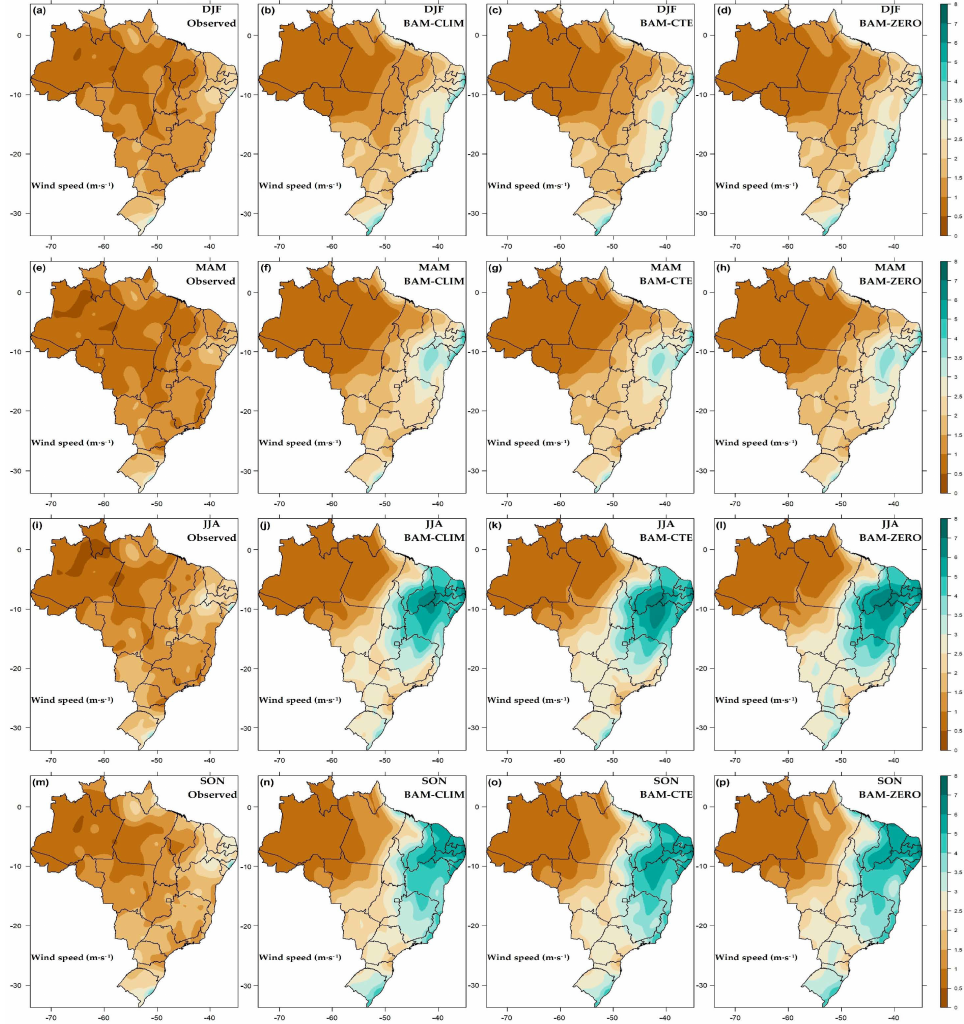
Figure 3. Seasonal averages of wind speed (m · s − 1 ). In the upper panel, values obtained for summer (DJF) from observations ( a ), BAM-CLIM ( b ), BAM-CTE ( c ), and BAM-ZERO ( d ). In the second panel, the same for autumn (MAM) from observations ( e ), BAM-CLIM ( f ), BAM-CTE ( g ), and BAM-ZERO ( h ). In the third panel, the same for winter (JJA) from observations ( i ), BAM-CLIM ( j ), BAM-CTE ( k ), and BAM-ZERO ( l ). In the last panel, the same for spring (SON) from observations ( m ), BAM-CLIM ( n ), BAM-CTE ( o ), and BAM-ZERO ( p